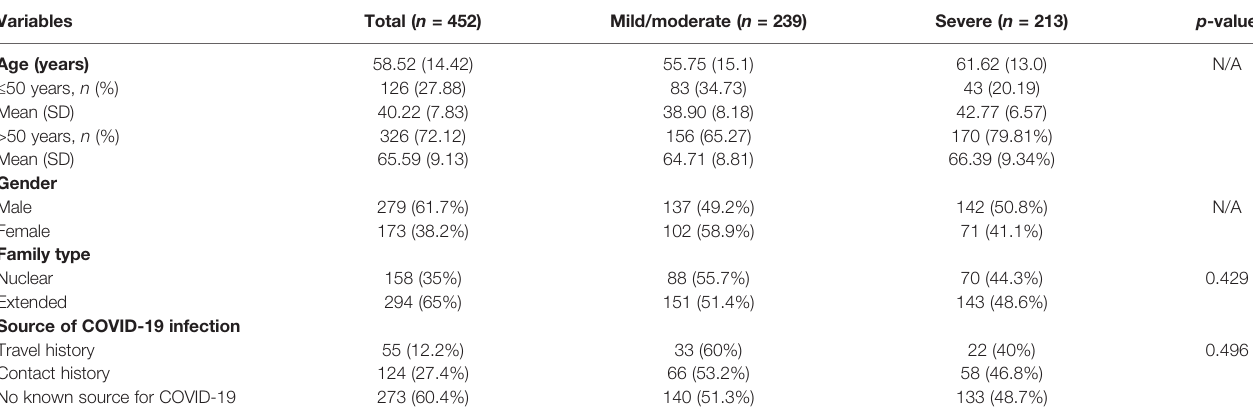
TABLE 1 | Epidemiological data of 452 symptomatic COVID-19 patients.